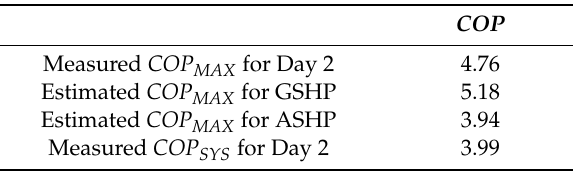
Table 5. Coe ffi cient of performance (COP) values for experimental values on Day 2 and estimated values for that day. GSHP: ground source heat pump; ASHP: air source heat